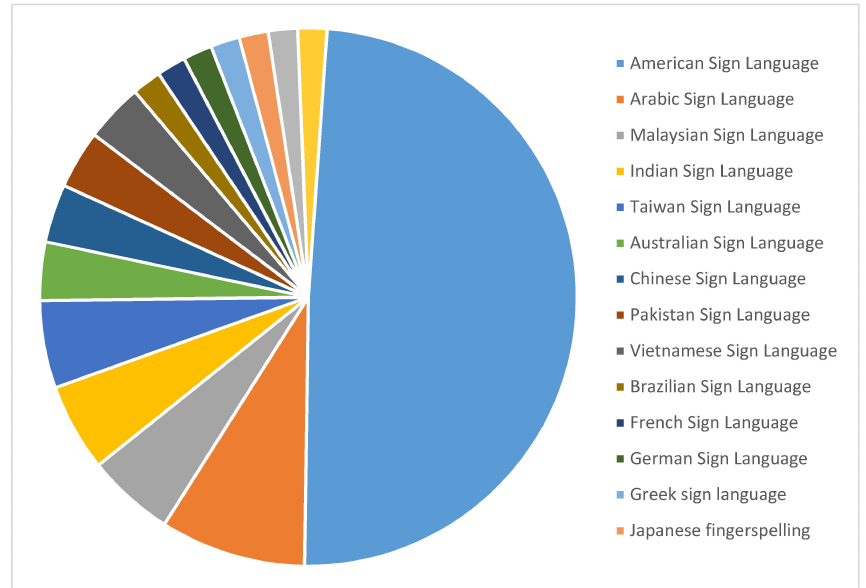
Figure 24. Number of articles published for each form of SL.